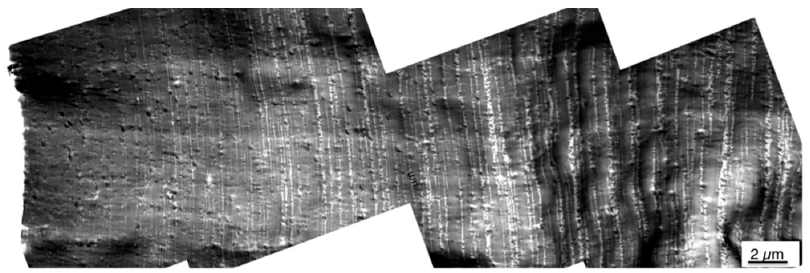
Figure 9. TEM micrographs visualizing the first 50 µm surface layer morphology profile of an injection-molded specimen made of the PC/ABS blend based on high molecular weight SAN.